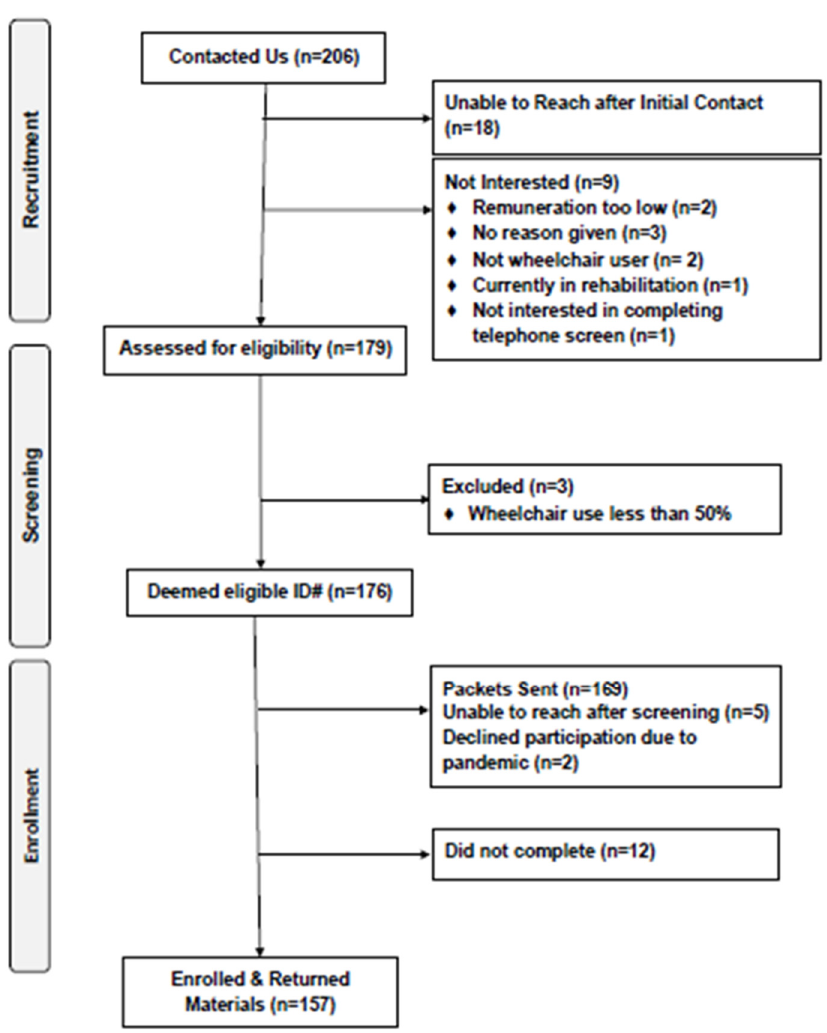
Figure 1. CONSORT Diagram.